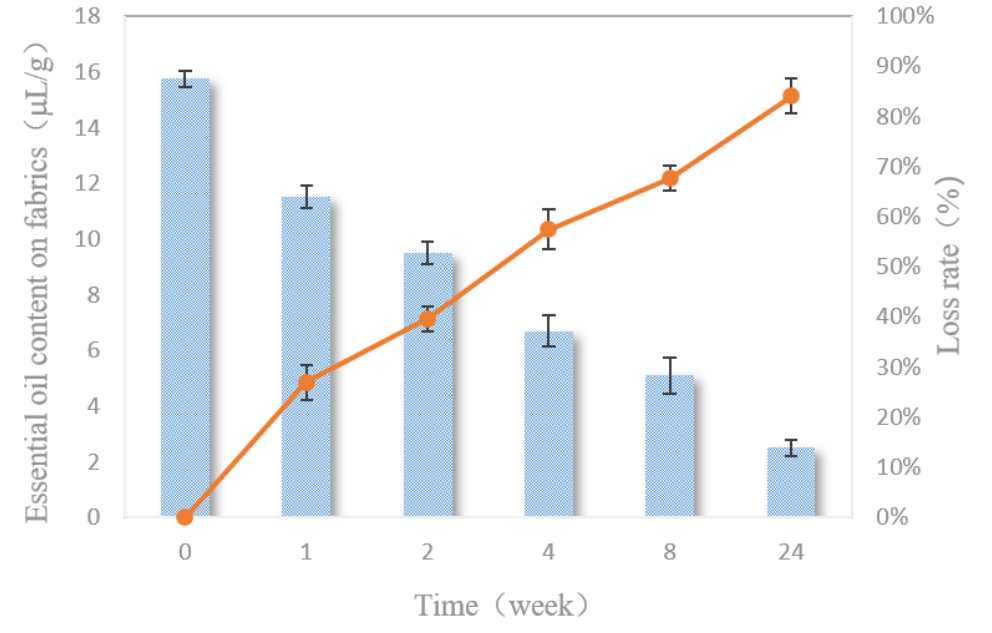
Figure 11. The release of essential oils on the finished fabrics.